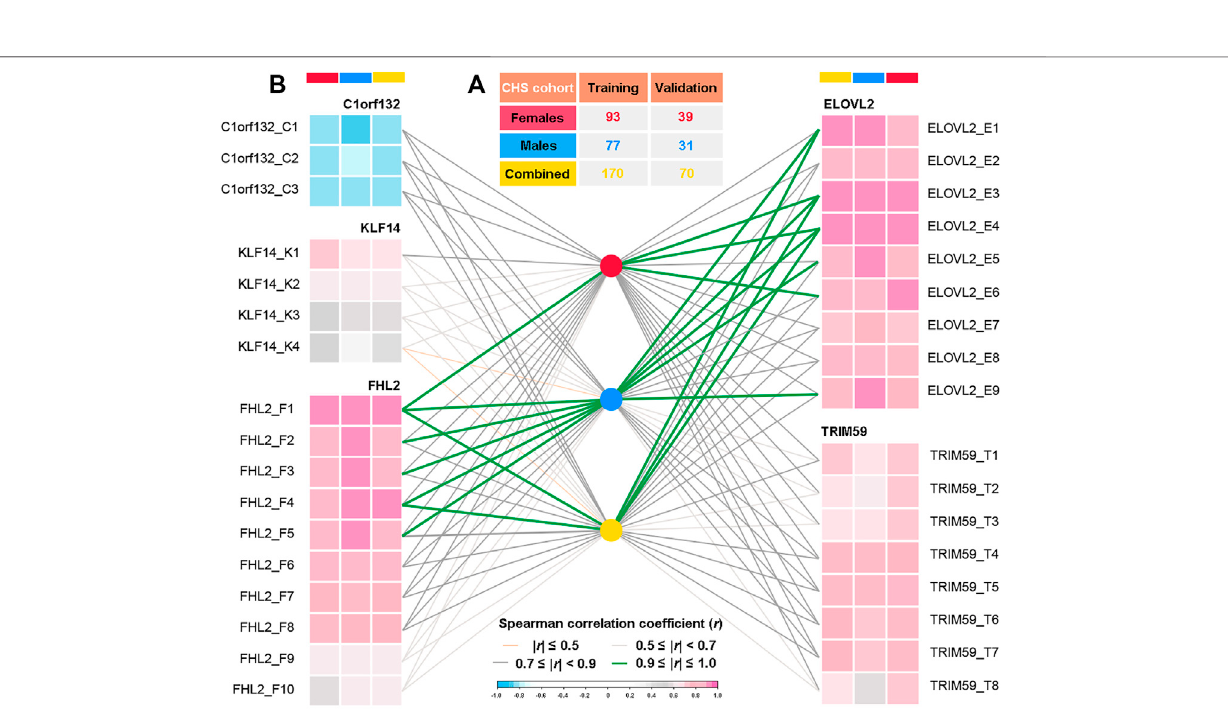
FIGURE 2 | Spearman correlation analysesbetween DNA methylation levels of34 CpGs located at fi ve genesand chronological ages of three different datasets in the CHS cohort ( n (cid:1) 240, blood samples). (A) Detailed population sizes of different datasets (in the CHS cohort, randomly 70%/30% for Training and Validation sets, detailed information in Supplementary Table S4 ). (B) Spearman correlations between chronological ages and DNA methylation levels at each CpG in three different gender datasets( r ,correlationcoef fi cient;0.9 ≤ |r| ≤ 1.0,veryhighcorrelation;0.7 ≤ |r| < 0.9,highcorrelation;0.5 ≤ |r| < 0.7,moderatecorrelation; |r| ≤ 0.5,lowcorrelation, details in Supplementary Table S5